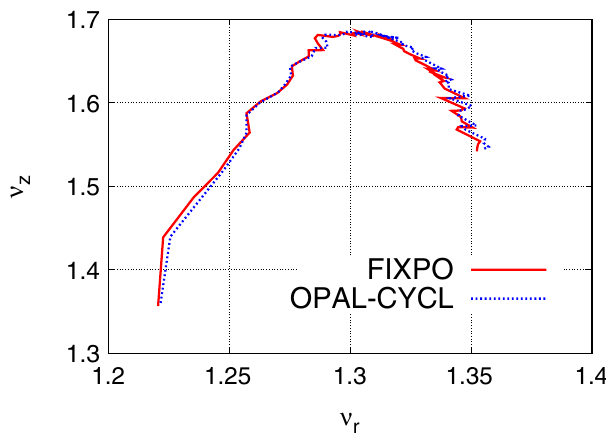
FIG. 5. (Color) Tune diagram of injector II cyclotron, compared with FIXPO code.